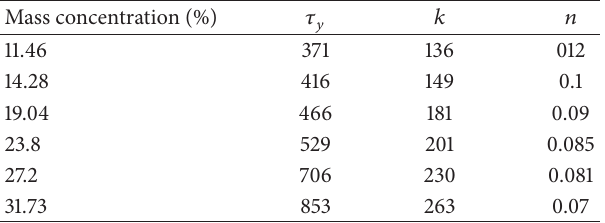
Figure 3: Shear stress versus shear rate of waste tissue pulp and several mass concentrations. Table 3: Herschel-Bulkley constants for waste tissue pulp suspen- sions as a function of the fiber mass concentration.